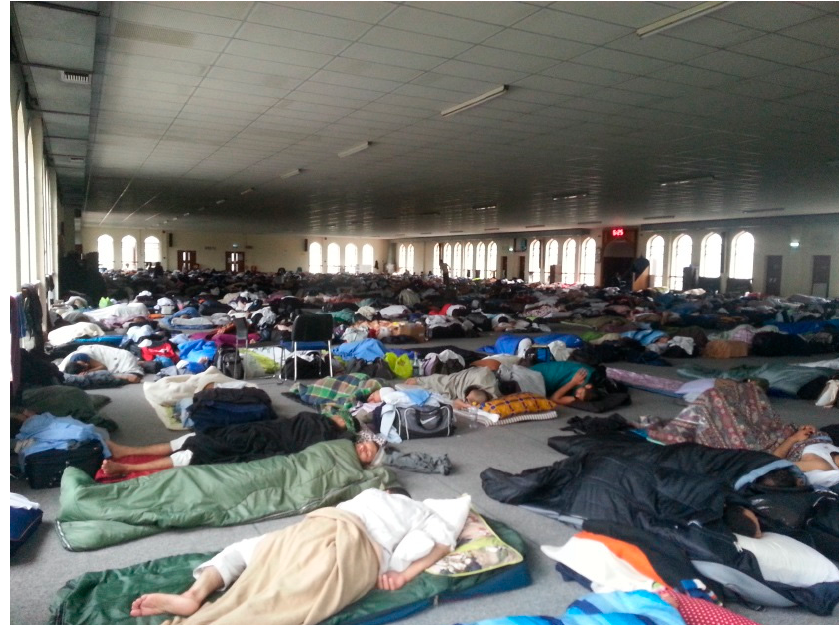
Figure 5. The upper floor of the large TJ complex in Dewsbury strewn, in Ziauddin Sardar’s (2004, p.